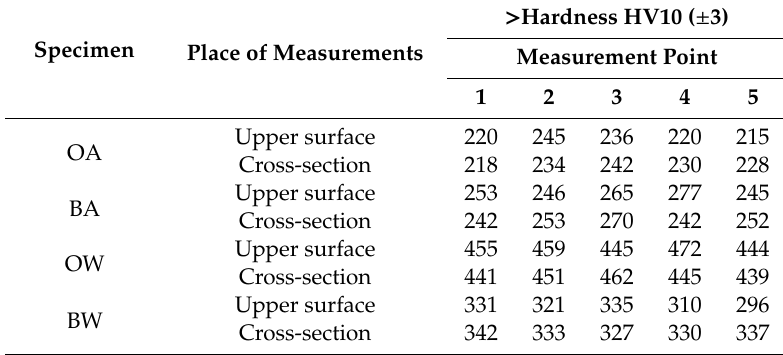
Table 3. The results of the hardness HV10 measurements.